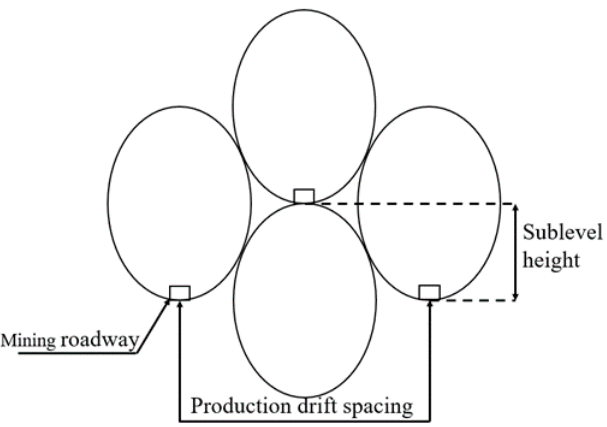
Figure 1. Arrangement of large space of discharged ellipsoid.